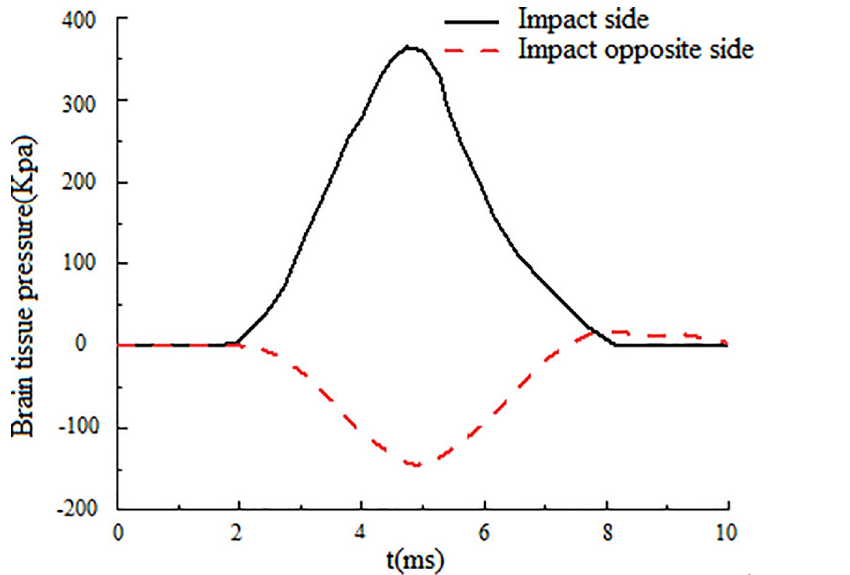
Fig 13. Intracranial pressure of frontal collision varies with time.